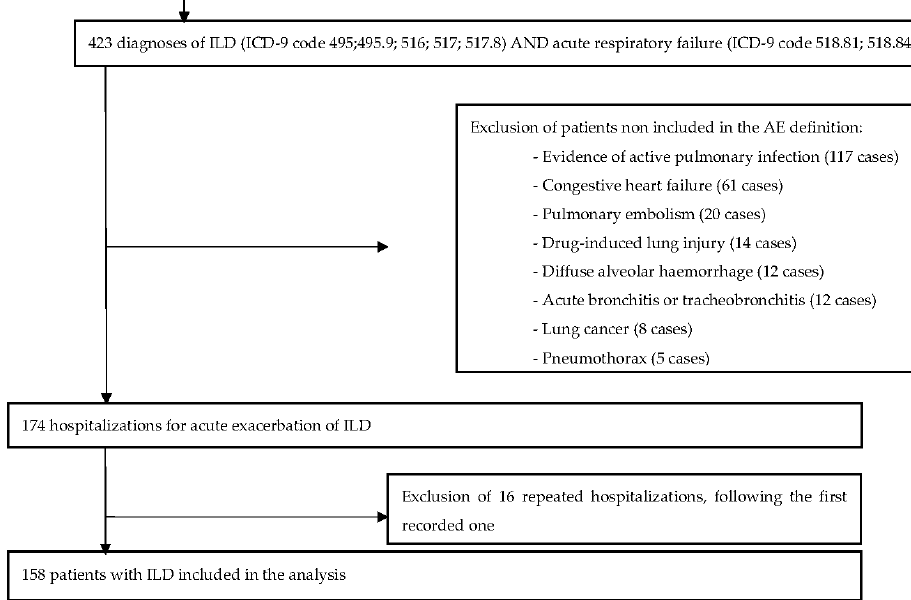
Figure 1. Flowchart of the study.